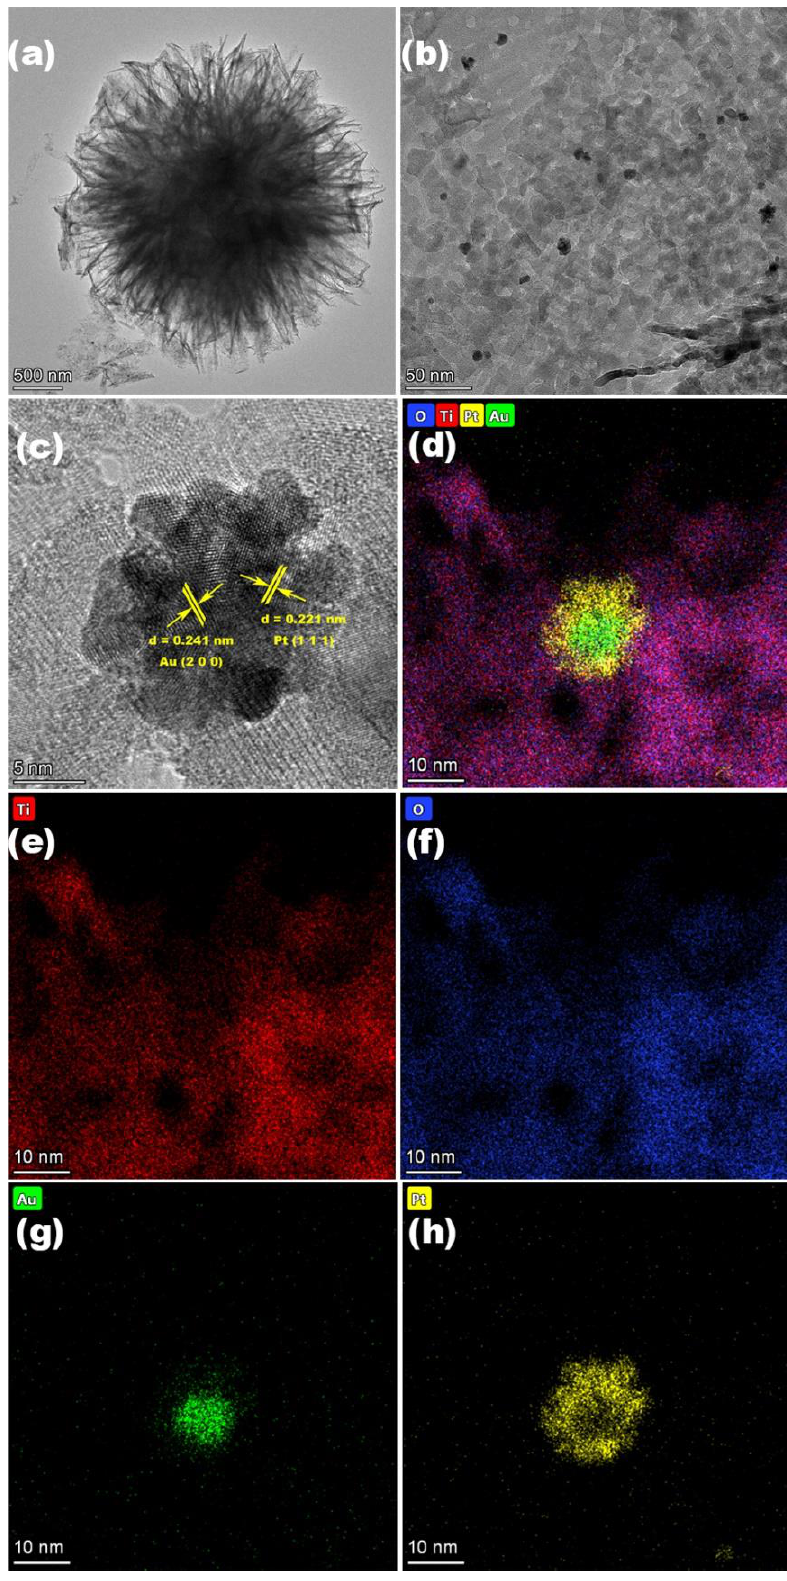
Figure 1. ( a , b ) TEM, ( c ) HRTEM images and ( d – h ) elemental mapping of AuPt – TiO 2 . As shown in Figure 2a, the elemental composition and crystalline phase of catalysts are analyzed by XRD patterns. According to PDF 21-1272, the anatase TiO 2 is shown to be present in all catalysts. Excluding the characteristic peaks of metals, the diffraction peaks of the modified catalysts are almost similar to those of pure TiO 2 . There is a weak peak at 39.7° shown in the XRD patterns of Pt – TiO 2 and AuPt – TiO 2 , revealing the presence of Pt. Similarly, the weak peak at 44.3° proves the presence of Au in Au – TiO 2 . However, a weak peak is observed at 44.3° in the AuPt – TiO 2 catalyst, which is speculated to be caused by